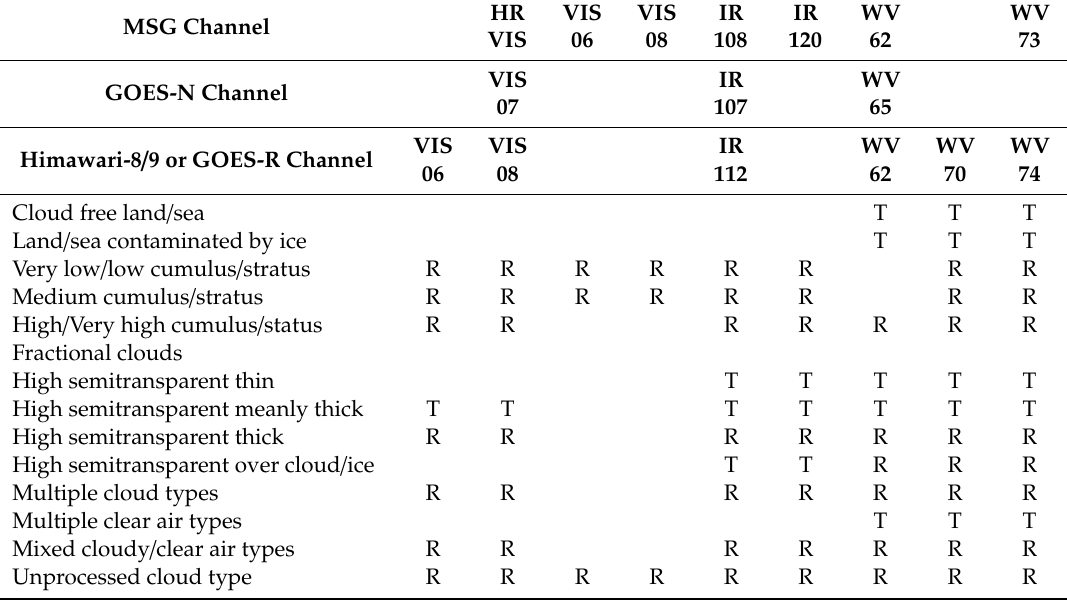
Table 1. AMV filtering related to the AMV cloud types (in rows) and the satellite channels used for the AMV calculation (in columns), and consideration of the cloud top pressure (T) or cloud representative pressure (R) in the EBBT height assignment method for the AMV